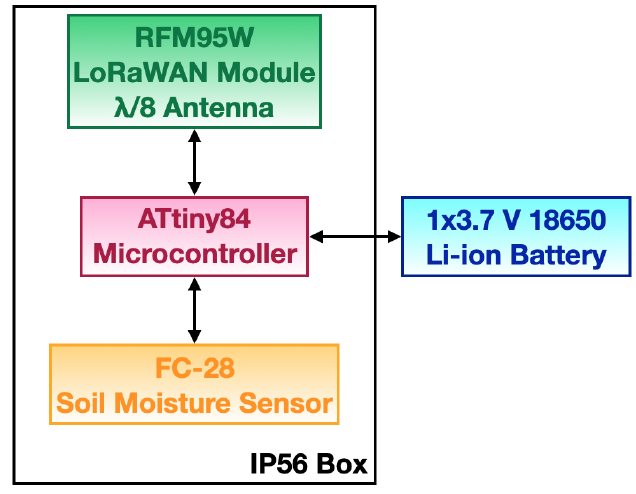
Figure 4. IoUT sensor node block scheme.